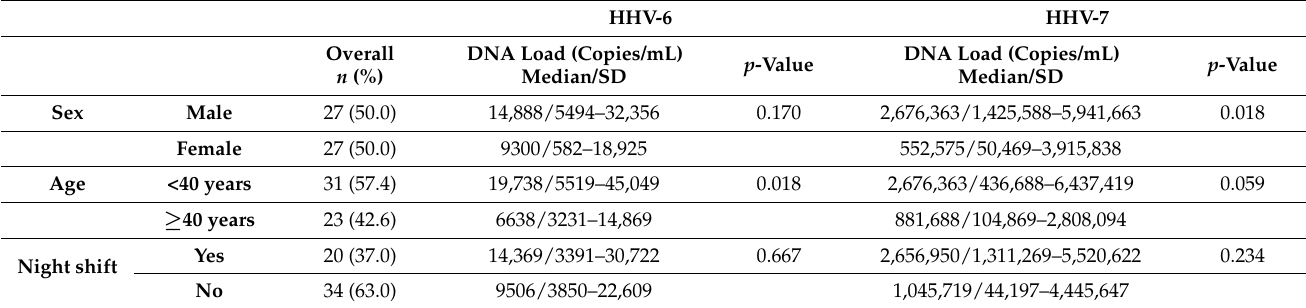
Table 1. Baselines of HHV-6 and HHV-7 DNA salivary shedding patterns.